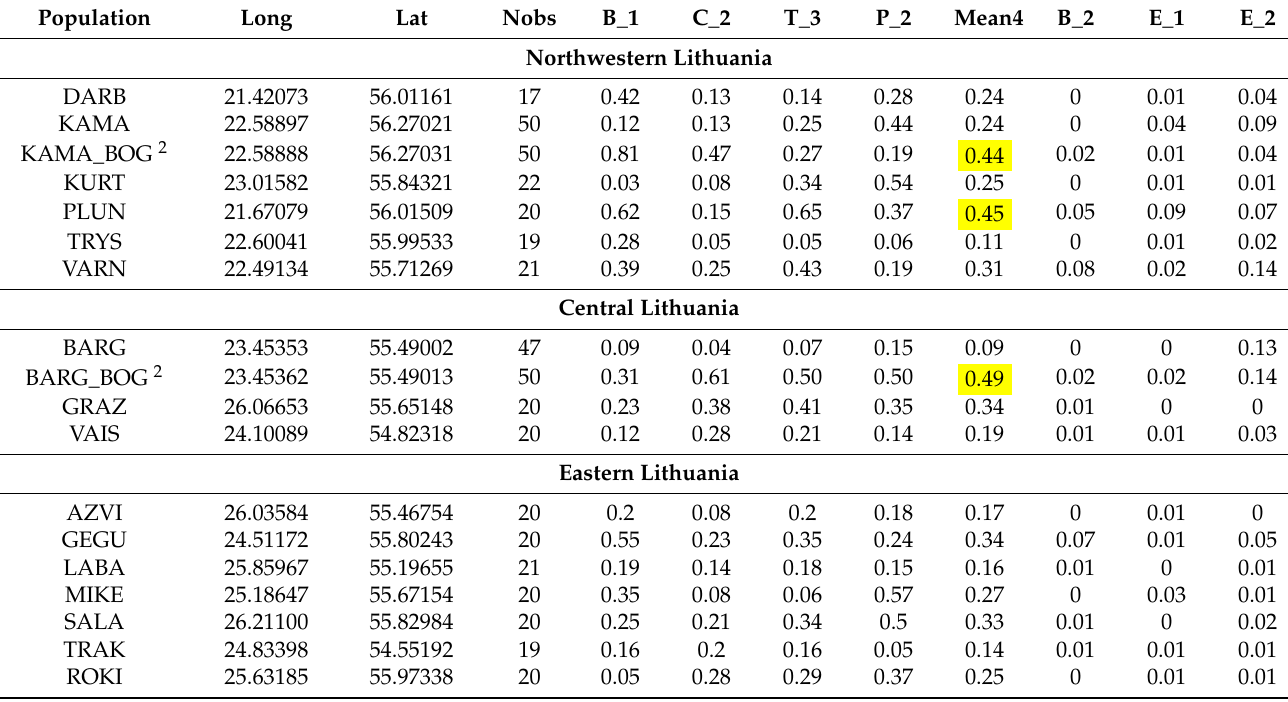
Table 1. Location and sample size of the reference populations as abbreviated in Figure 1 and the GENECLASS assignment probabilities of the seven ancient Scots pine individuals to these reference populations, based on nuclear microsatellite markers. Nobs is the number of trees. The assignment probabilities vary from 0 to 1, where the values closer to 1 indicate strong genetic associations. Mean4 is the mean assignment probability of the four sea pine samples (B_1, C_2, T_3, P_2) that gave marked, above-zero associations with the inland populations (high values highlighted in yellow). Note that ancient pine samples B_2, E_1, and E_2 are circa 300 years older than the remaining ancient pines (Table 2). Population